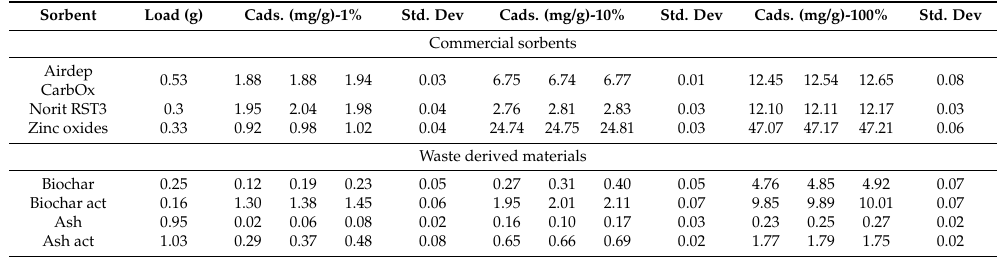
Table 3. Adsorption capacity for waste-derived materials and commercial carbons for H 2 S removal.